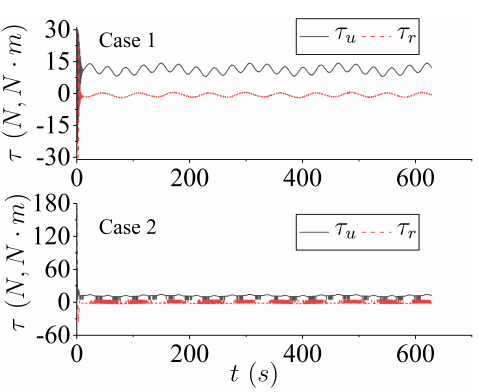
Figure 5. The estimation results of DO in Case 1.